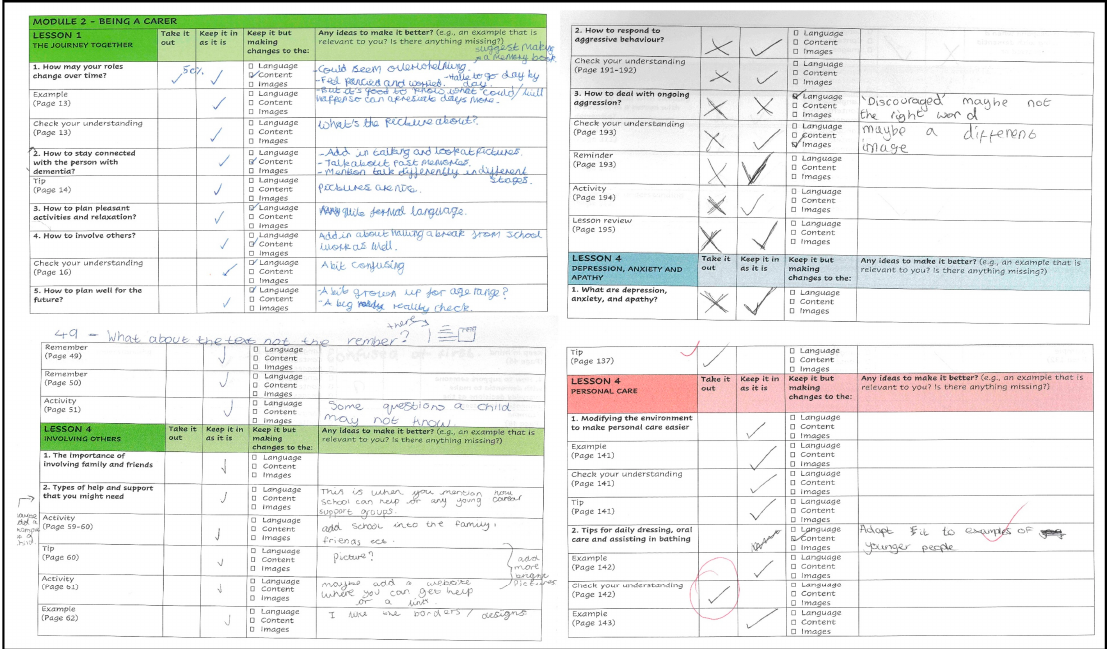
Figure 3. Example of young carers feedback (workbooks) .